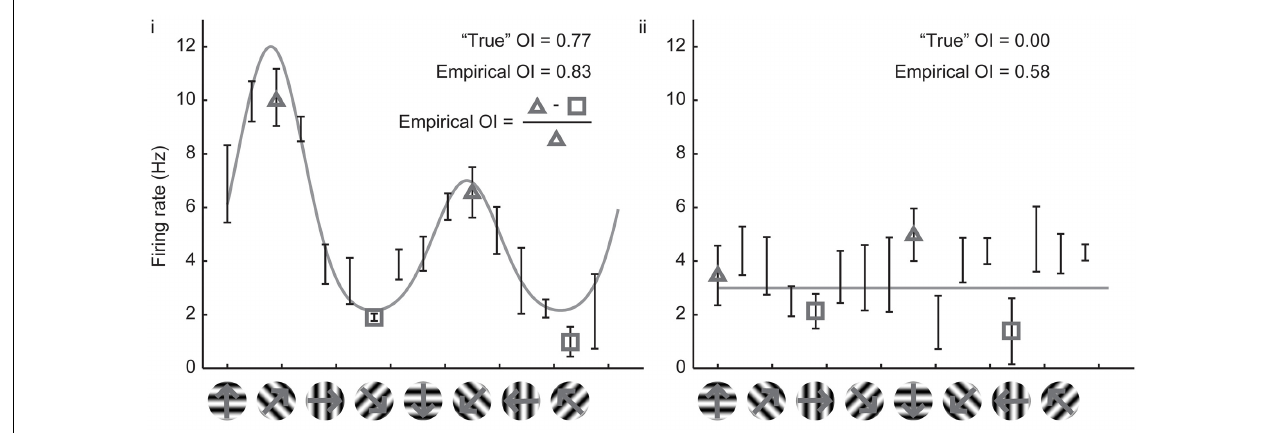
FIGURE 2 | Calculation of the empirical orientation selectivity index ( OI ). (i) Simulated responses (10 trials, 5Hz per trial noise) to a model cell with an underlying direction tuning curve indicated in gray. Error bars indicate standard error around the mean of the simulated responses. To calculate OI , responses from the preferred orientation angle are averaged together (triangles) and the responses to the orthogonal angles (squares) are